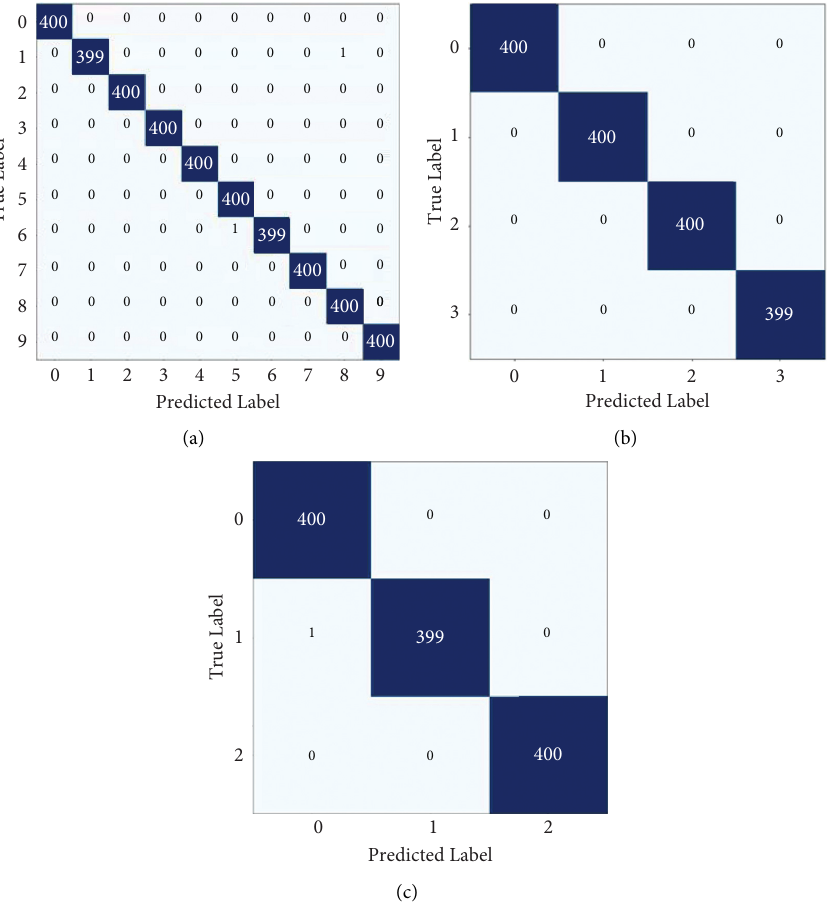
Figure 5: Confusion matrices for (a) CWRU, (b) Jiangnan, and (c) Paderborn